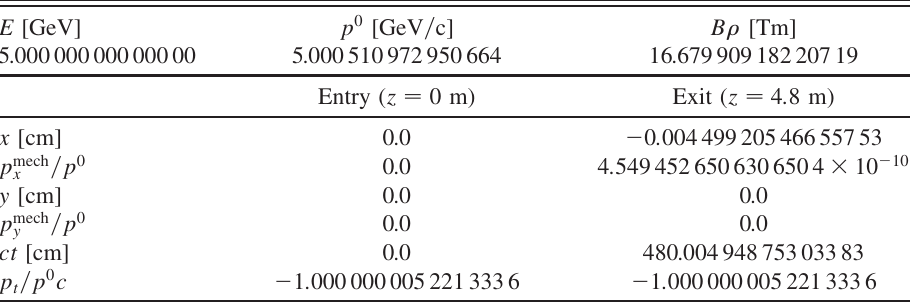
TABLE I. Design-orbit